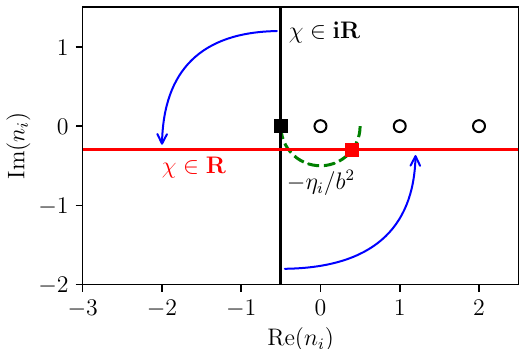
Figure 2 . The possible values of n i (3.8) during the deformation of the contour of χ . The latter is i R when b 2 > 0 , so n belongs to a vertical line shifted by − η 2 < 0 (indicated by the black i i /b square). As b 2 = | b 2 | e − i θ rotates clockwise ( θ increases from 0 to π ), the χ contour rotates anti- clockwise towards R . Meanwhile − η 2 follows the green dashed half-circle below the real axis, i /b and arrives at the red square as θ = π − (cid:15) . Then, n belongs to the horizontal red line, and always i satisfies Im( n ) < 0 (which is important for the elementary cycle decomposition, see above (3.12) i and also (2.6)) . We observe that n is away from the poles of Γ( − n ) (empty dots) throughout the i i contour deformation